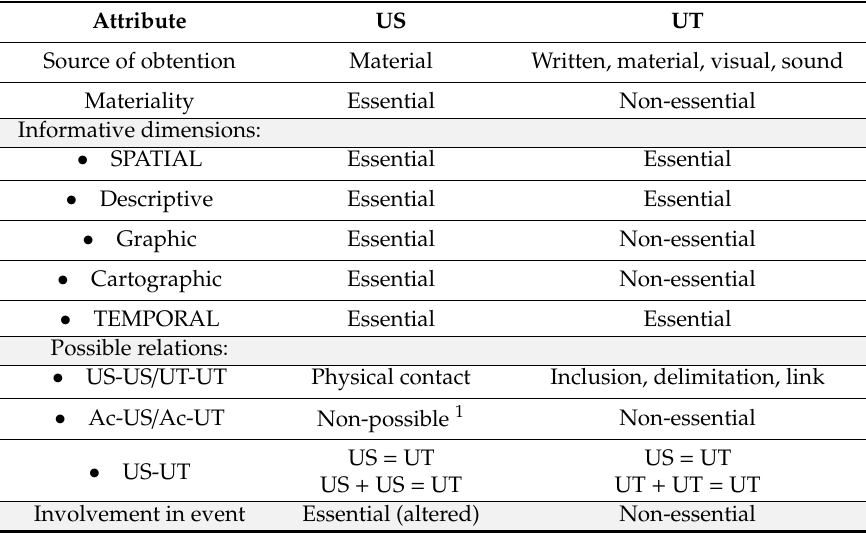
Table 3. Units of information (US / UT) ontological